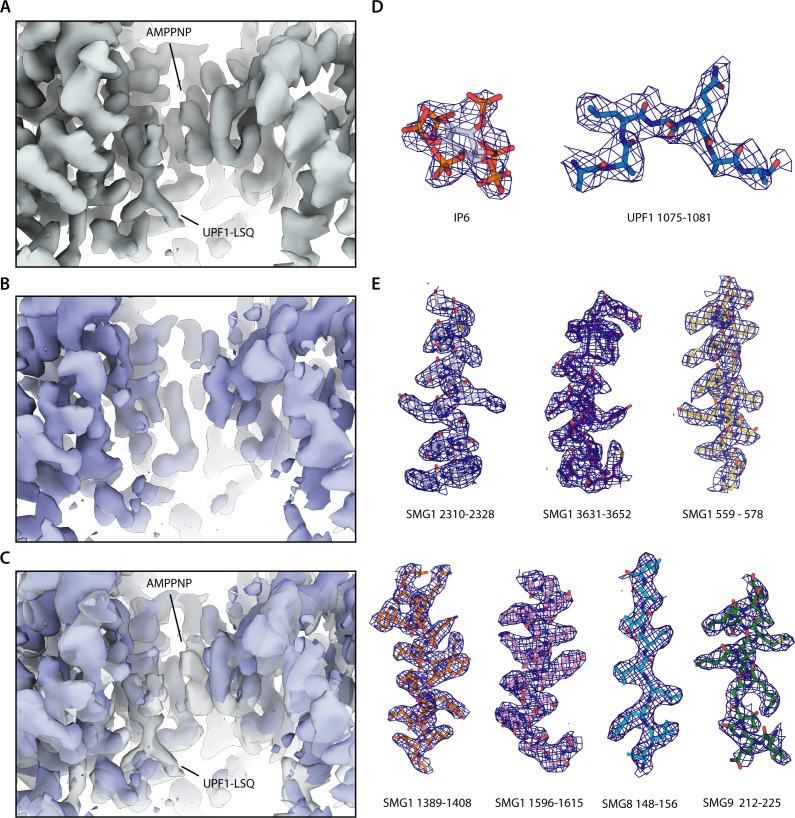
Quality of the reconstructed density.(A) Active site density reported in this study. Densities attributed to either AMPPNP or UPF1 peptide are indicated. (B) Active site density of the apo SMG1-8-9 reconstruction reported previously (EMDB 10347). (C) Overlay of the active site densities shown in A and B with the active site density reported in this study shown in transparent grey and density of apo SMG1-8-9 (EMDB 10347) shown in blue. Densities attributed to either AMPPNP or UPF-LSQ are indicated. (D) Model of IP6 and UPF1-LSQ with the corresponding density shown as a blue mesh. Colors of the model as in Figure 1. (E) Additional parts of the model with the corresponding density shown as in B.